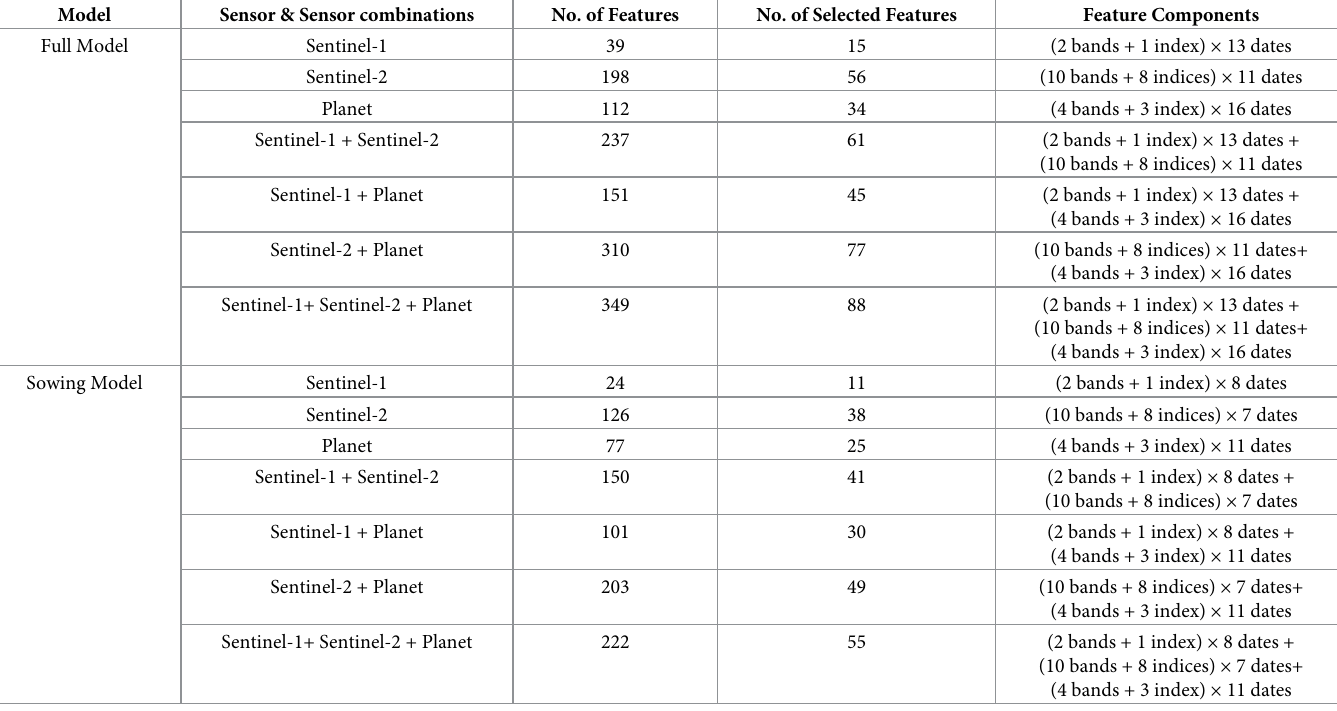
Table 3. Feature components of different sensor and sensor combinations and full and sowing season